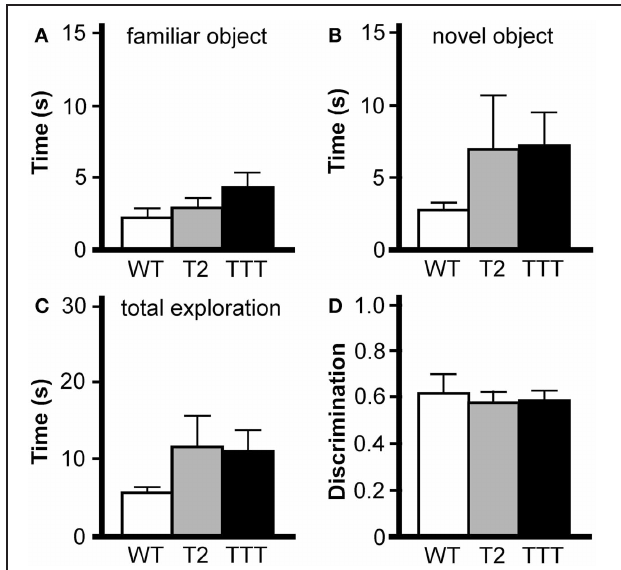
FIGURE 5 | Novel object recognition in mice lacking Trek channels. Wild-type (WT, white), Trek2 − / − (T2, gray), and Trek1/2 / Traak − / − (TTT, black) mice were evaluated in a novel object recognition task ( n = 7–9 per group). No genotype-dependent differences were observed in terms of the amount of time spent during a 5min (300s) test session interacting with the familiar object (A) [ F ( 2 , 22 ) = 1 . 7, P = 0 . 21], time spent interacting with the novel object (B) [ F ( 2 , 22 ) = 1 . 0, P = 0 . 39], total time interacting with the familiar and novel object (C) [ F ( 2 , 22 ) = 1 . 2, P = 0 . 31], or in object discrimination ratio (D) [ F ( 2 , 22 ) = 0 . 1, P = 0 . 87], defined as the ratio of time spent exploring the novel object to the total time spent exploring both objects [time novel /(time familiar +time novel )].